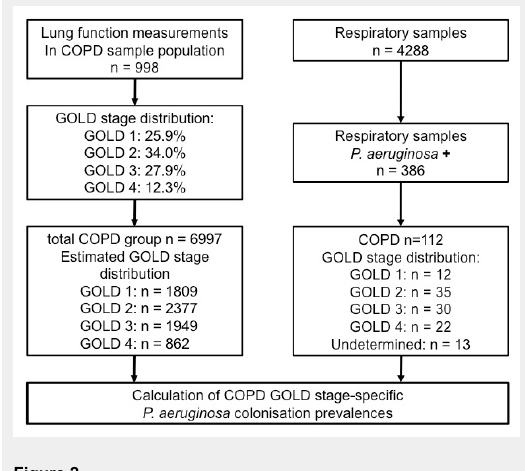
Algorithm used to perform analyses and estimations of prevalences. Patient populations, lung functions and respiratory samples were defined in the methods section. COPD severity was graded according to the GOLD classification as detailed in the methods